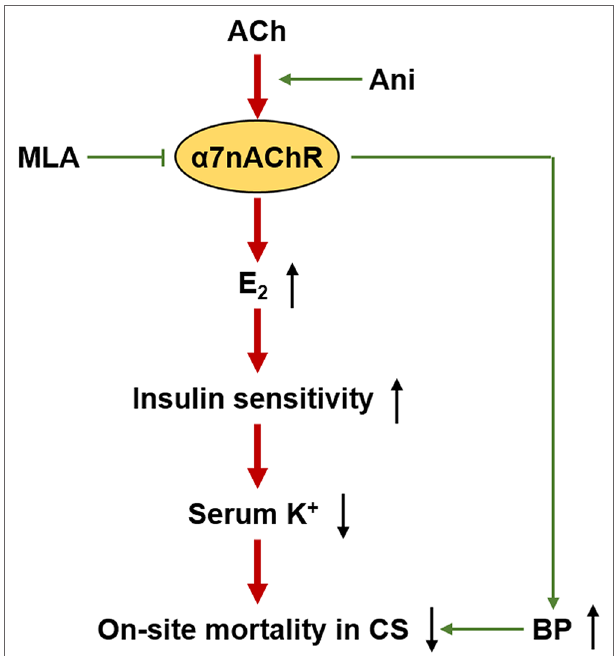
FIgURE 9 | Proposed mechanism for anisodamine to decrease on-site mortality in crush syndrome. ACh, acetylcholine; BP, blood